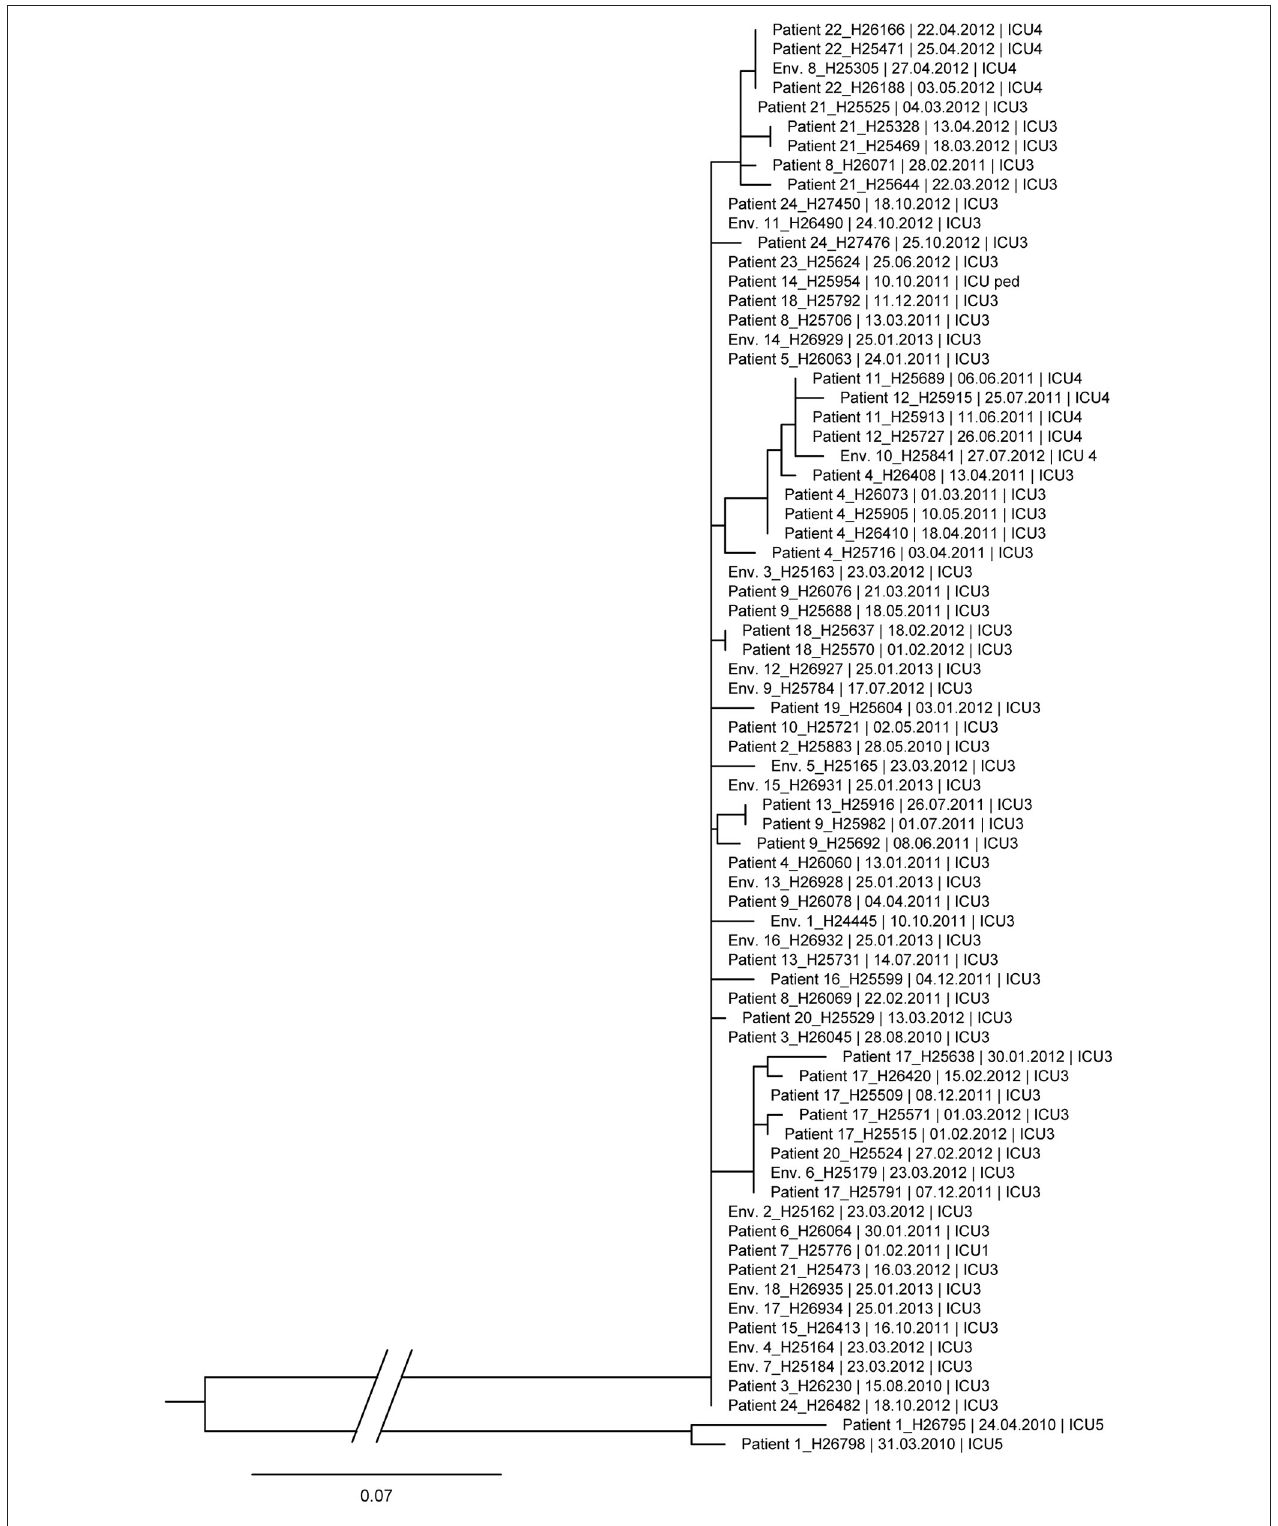
FIGURE 2 | Maximum likelihood tree based on SNP variable sites of all DLST 1–18 isolates. Isolate identification (patient or environment), date and unit of sampling are indicated. Differences of 0–14 SNP were observed between isolates of the outbreak (without Patient 1).